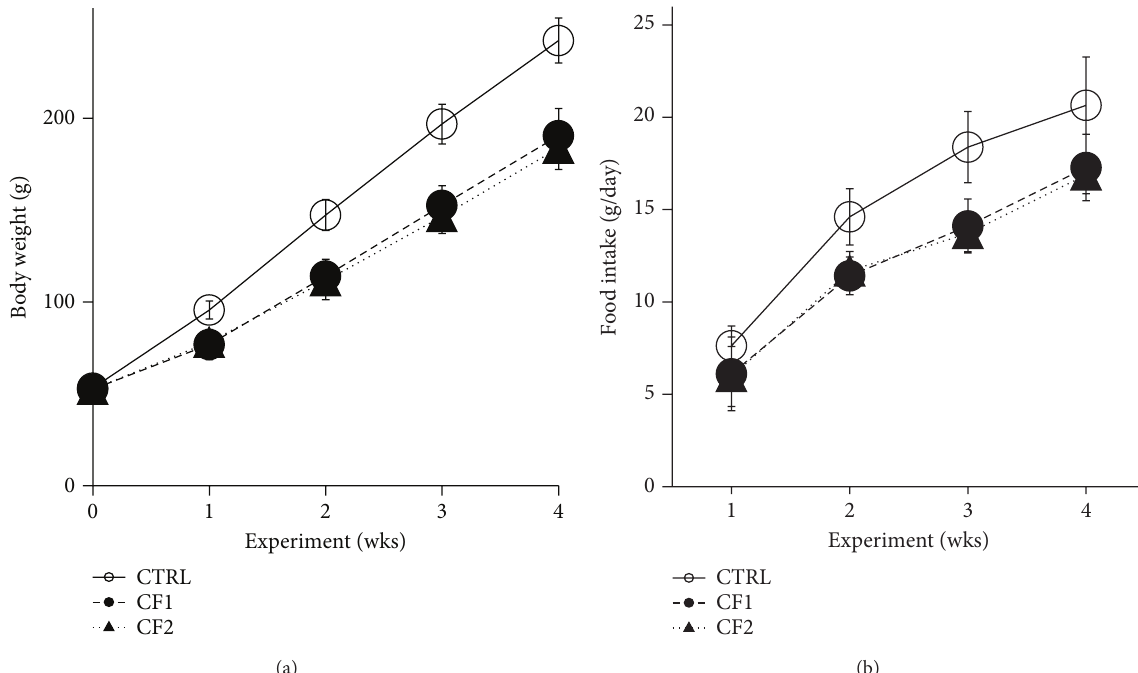
Figure 1: Effect of caffeine exposure on body weight and food intake in immature male rats. (a) Average body weight measured in the rats fed with vehicle or caffeine is depicted every week although body weight was measured daily. (b) Average daily food consumption was calculated by averaging the amount of food consumed over one week and is depicted for each week. Values are expressed as mean ± SD. Open circle, CTRL (control); filled circle, CF1 (caffeine 120mg/kg/day); filled triangle, CF2 (caffeine 180